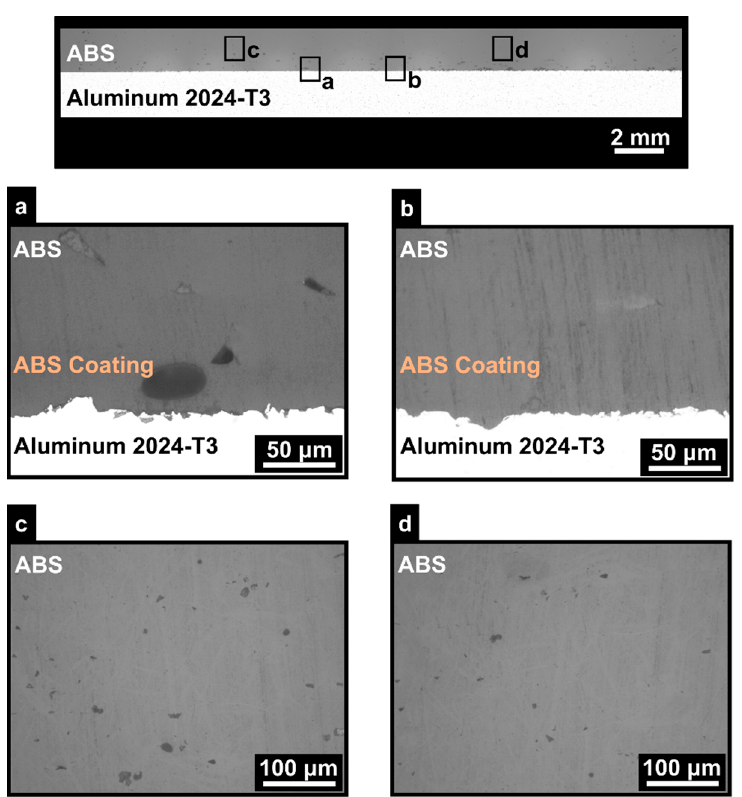
Figure 24. Microstructure for aluminum 2024-T3/ABS hybrid joints obtained by the AddJoining process: ( a ) voids in the ABS coating layer, ( b ) the interface between ABS and the aluminum, and ( c , d ) void formation in the printed ABS (PT: 280 °C, RT: 0.1 mm; DS: 60 mm/s; AC: 25 wt.%; NC: 12).